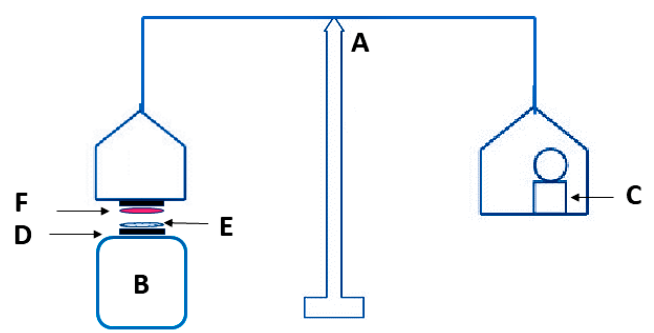
Figure 1. Modified balance assembly for mucoadhesion measurement. A : balance; B : beaker; C : weight; D : double sided adhesive tape; E : formulation; and F : goat skin.